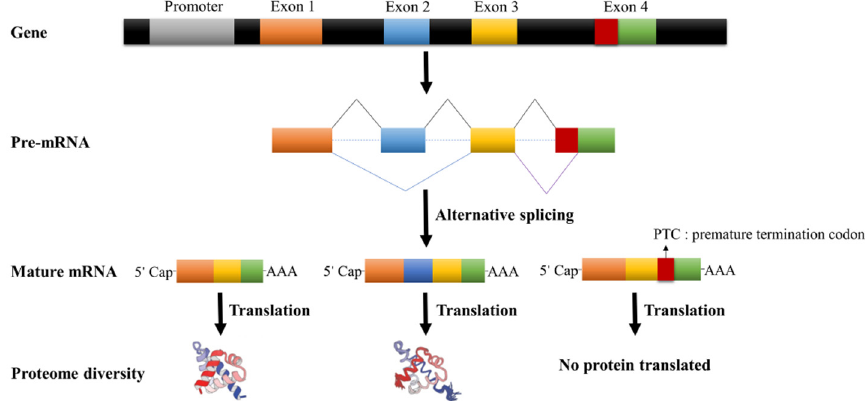
Figure 3. Alternative splicing process.